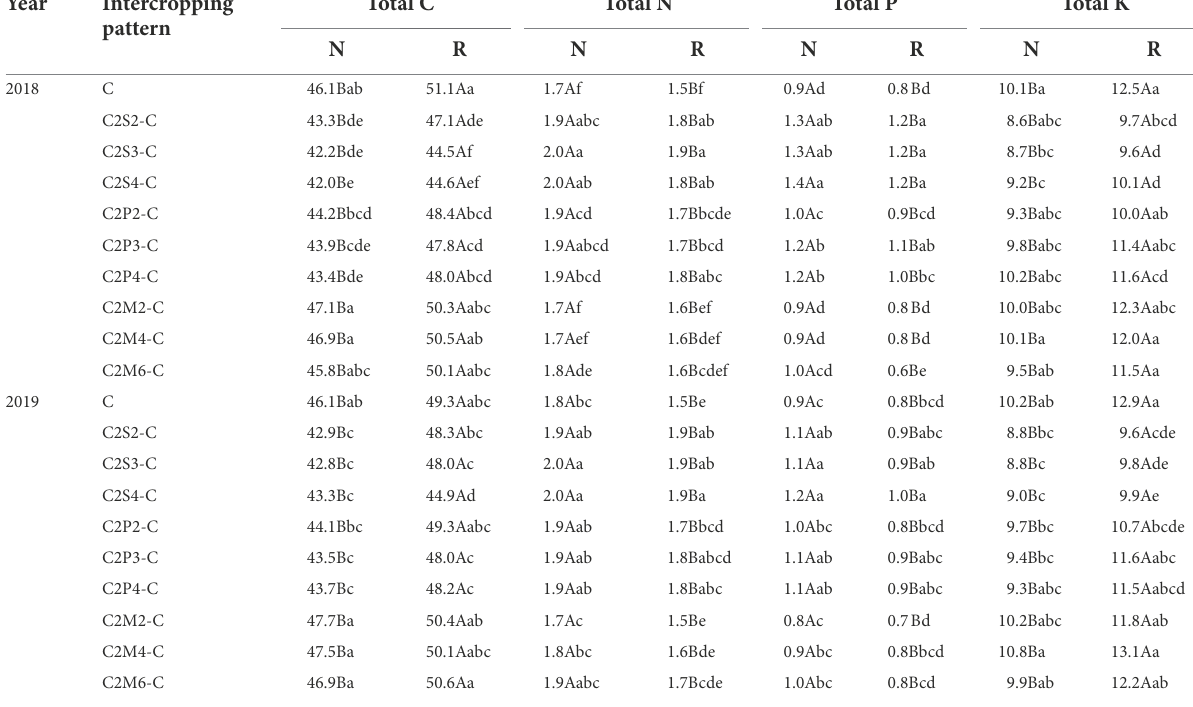
TABLE 6 Effects of different intercropping planting patterns and fertilizer levels on the nutrient elements (C, N, P, and K) in corn leaves in 2018 and 2019. Year Intercropping pattern